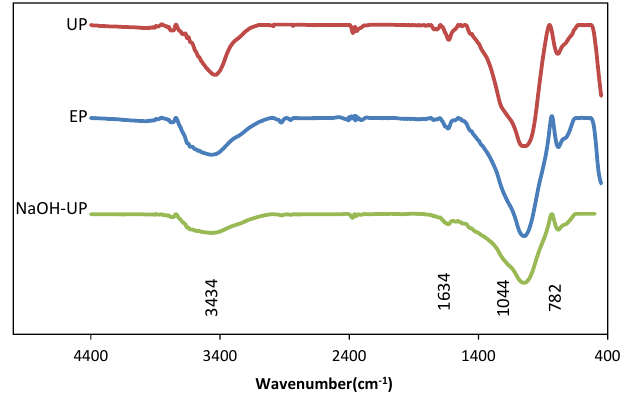
Fig. 2. FTIR spectra of UP, EP and NaOH-UP.